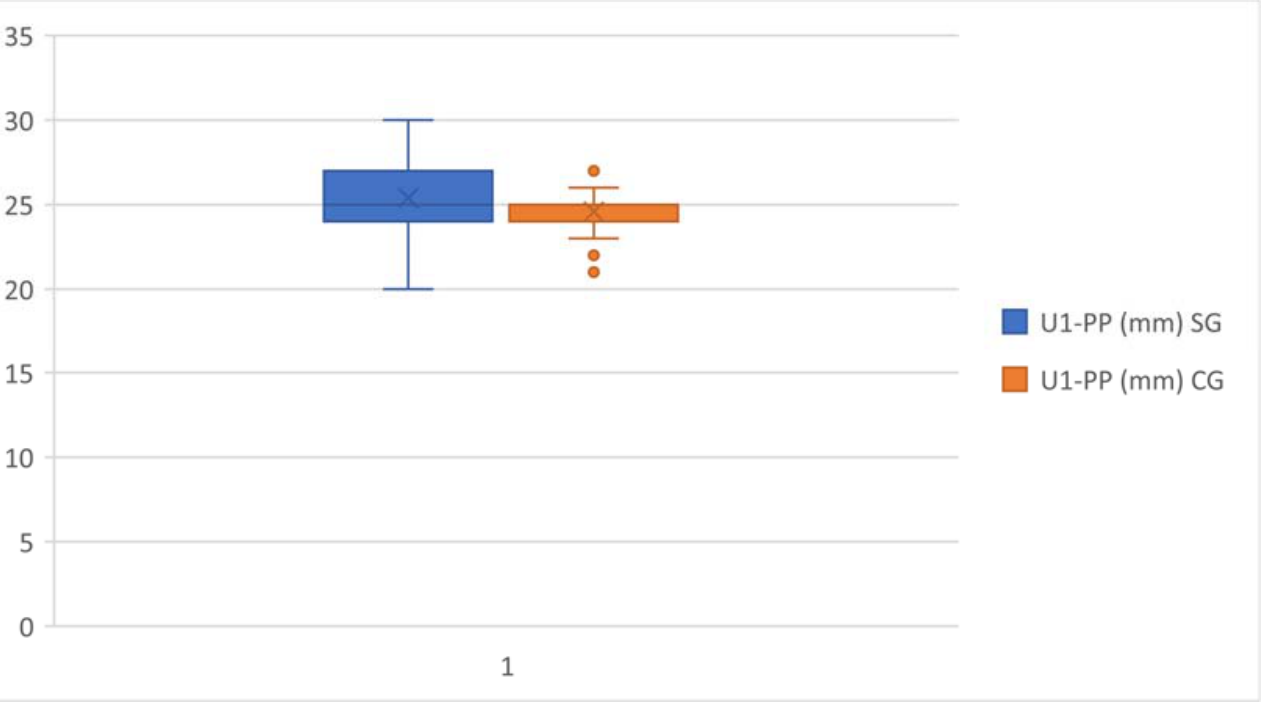
Figure 7. U1-PP comparison in the study group and the control group. The exposure of the upper incisors, indicated by Is–Sts, showed a significant increase in the study group compared with the control group (Figure